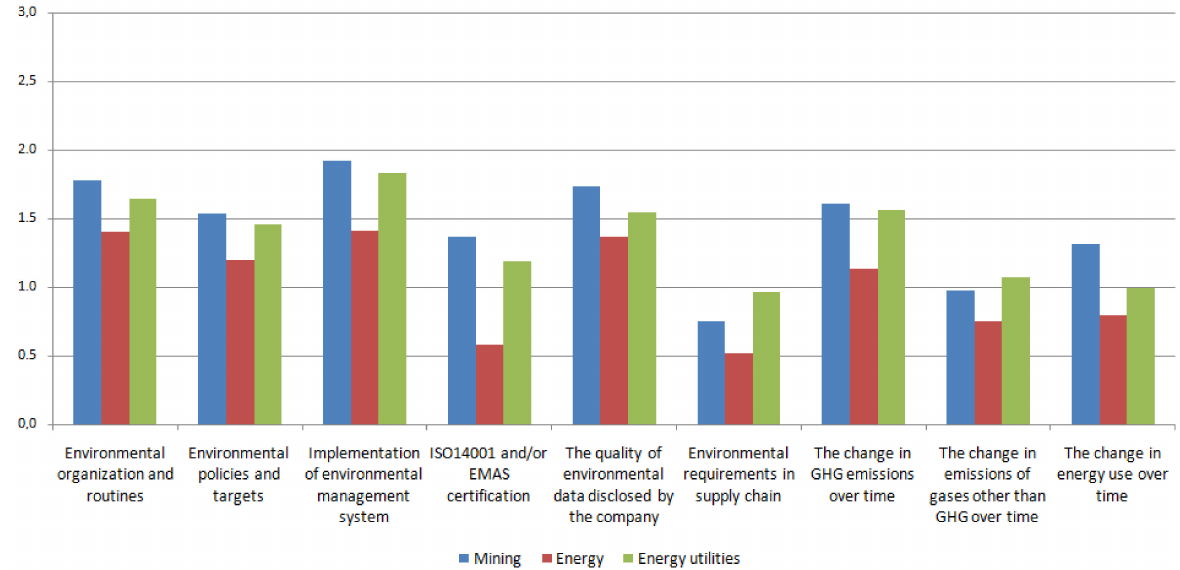
Figure 2. Comparison of mean values of grades obtained in environmental indicators by mining, energy, and energy utilities